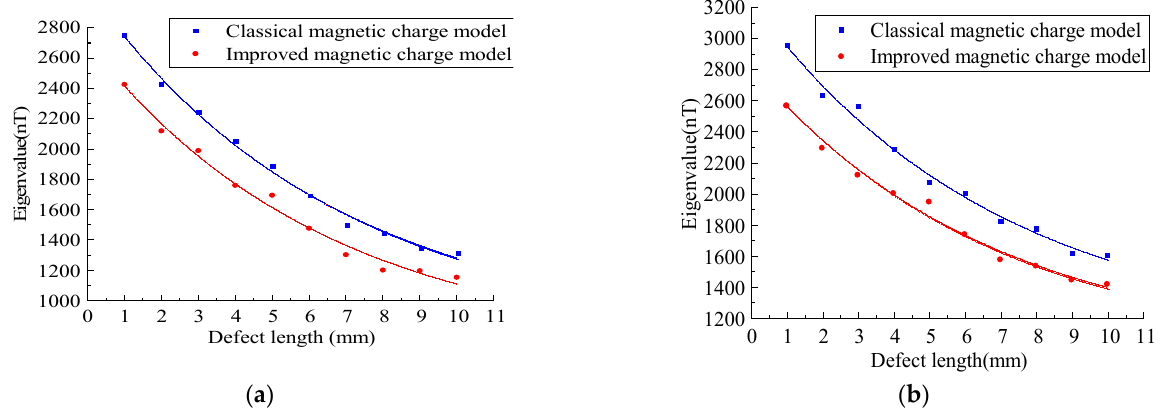
Figure 13. Analysis of characteristic values under different defect lengths. ( a ) Analysis of axial eigenvalues under different defect lengths. ( b ) Analysis of radial eigenvalues under different defect lengths.